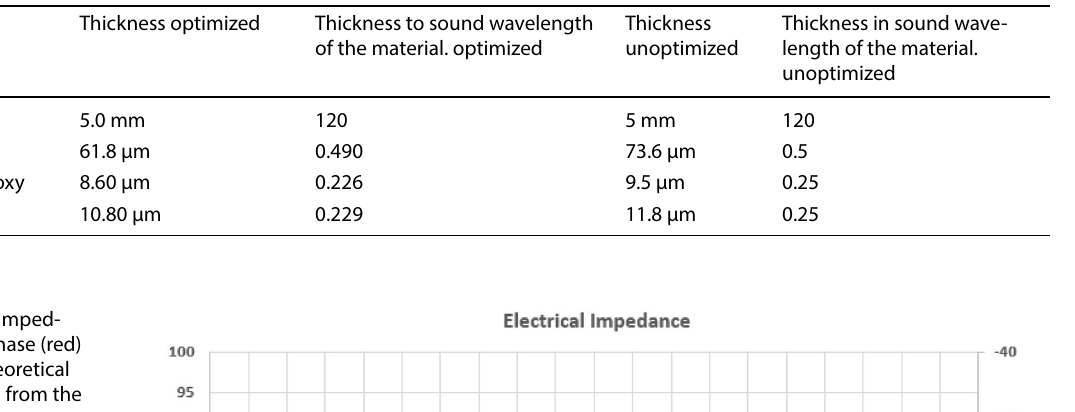
Table 3 Optimized probe layer thicknesses Thickness optimized Thickness to sound wavelength of the material. optimized